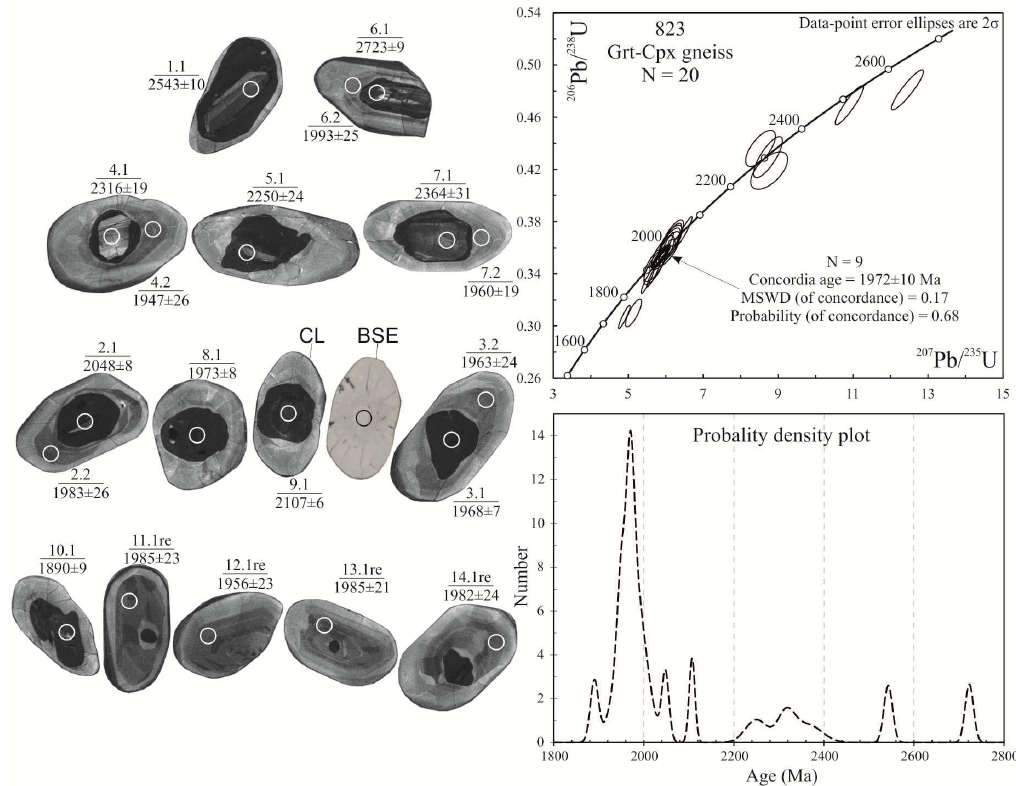
Figure 6. Cathodoluminescence (CL) images and ages of zircons from the garnet–clinopyroxene gneiss (sample 823). White circles mark analytical craters, and the nearby numerals are the numbers of the analytical spots (numerators) and 207 Pb/ 206 Pb age (denominators). The craters are 20 µm in diameter.